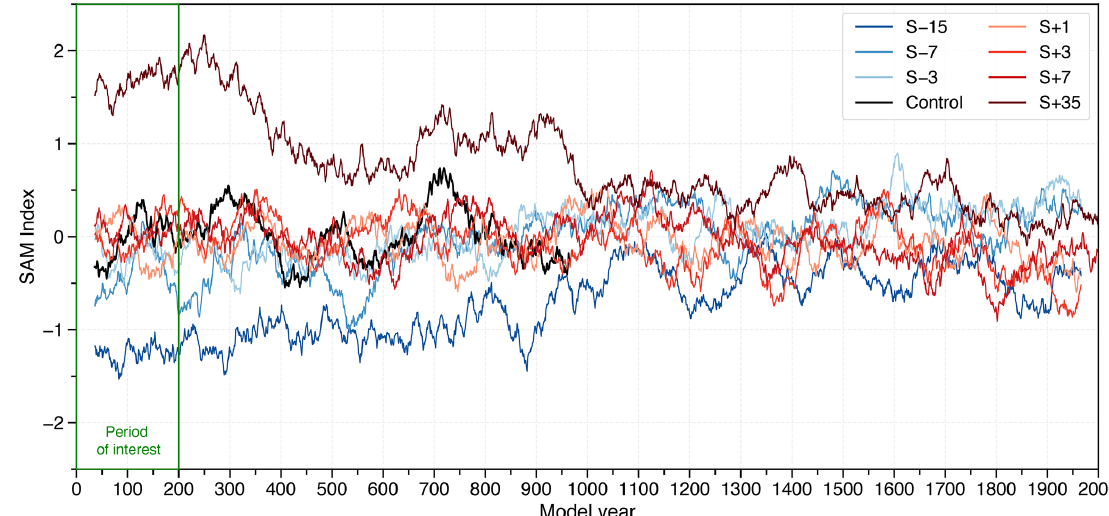
Figure 4. The 70-year moving average for the annual SAM index for each solar constant simulation. The period of interest in this study (first 200 years) is indicated with a green